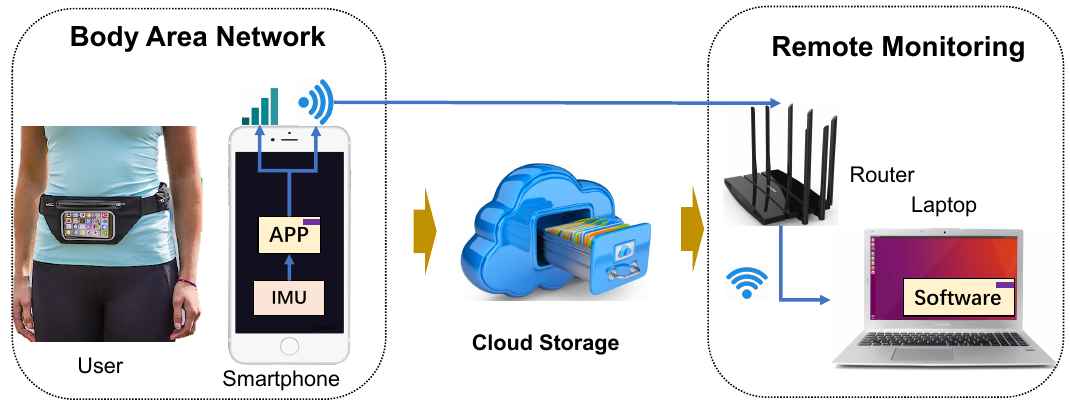
Figure 1. The schematic diagram of data collection and wireless communication between the user carrying the mobile device and the data analyzing unit (laptop). The activities can be identified on both smartphone and PC platform. The cloud storage can save the collected signals for future